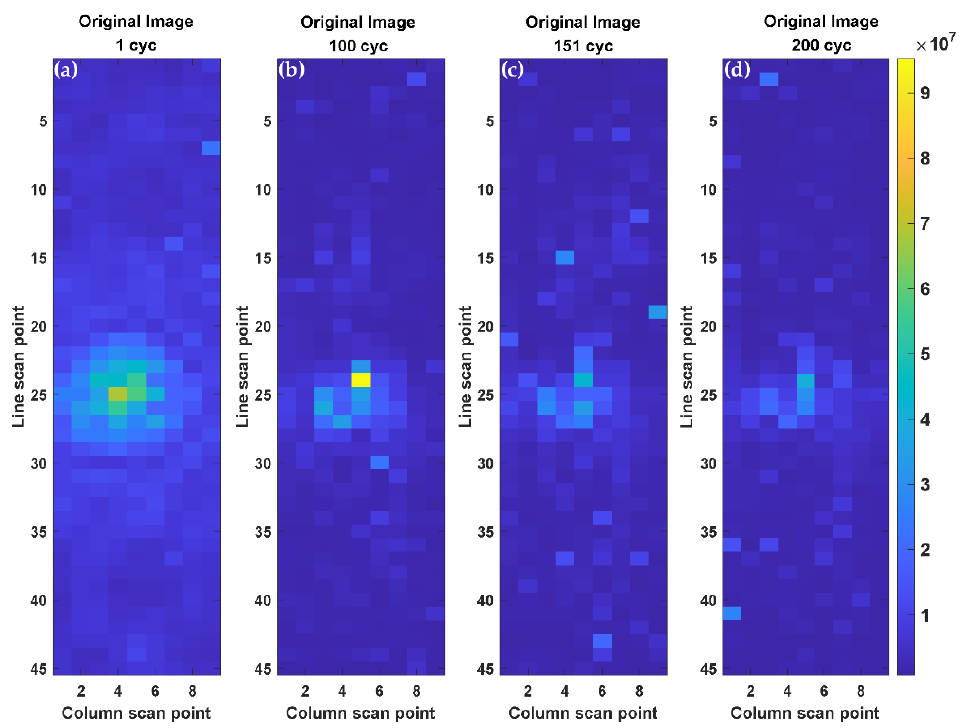
Figure 10. UGW spectrum diagram of lithium-ion batteries with different aging degrees. ( a ) 1 cyc; ( b ) 100 cyc; ( c ) 151 cyc; ( d ) 200 cyc.